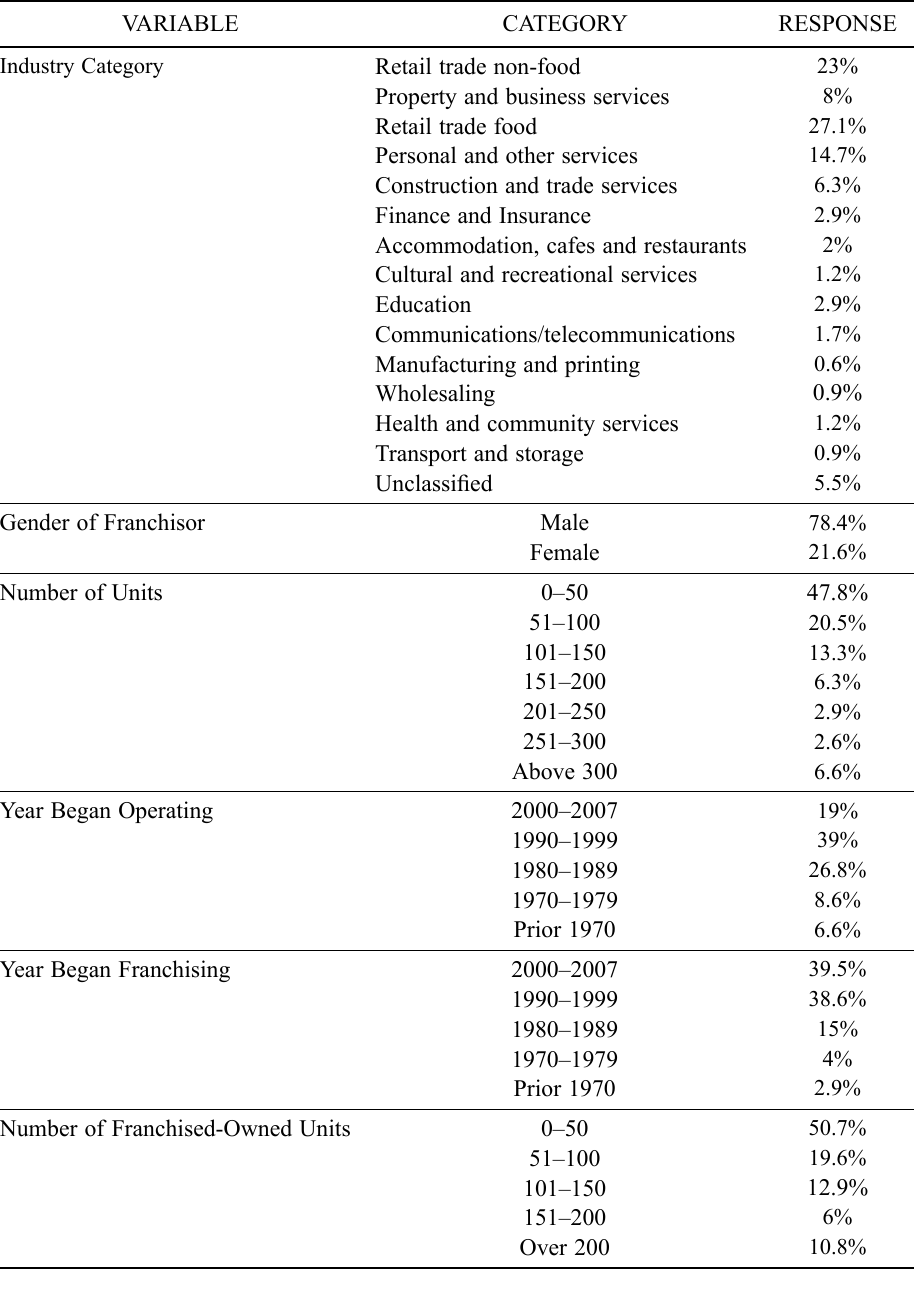
Table 2. Profile of